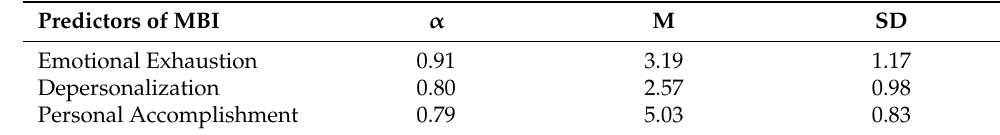
Table 2. Results in predictors of MBI burnout methodology: α , M, SD. Predictors of MBI α M Emotional Exhaustion